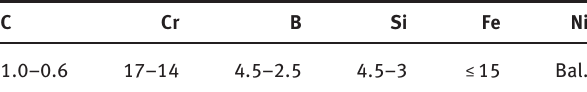
Table 3: Nominal chemical composition of Ni-based alloy powders (wt%).